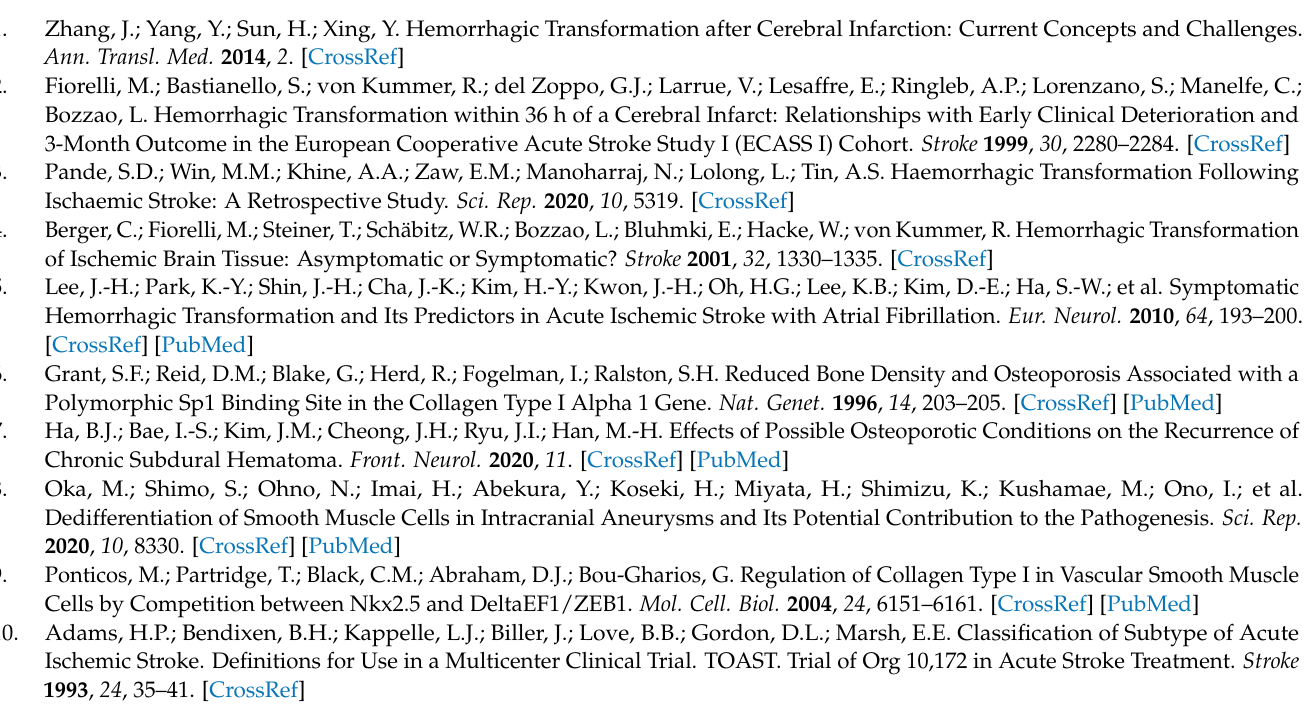
cancellous bone, Figure S2: Examples of PH type 1 and 2 HT in study patients with cardioembolic stroke, Figure S3: Measurement of the cerebral infarction volume, Figure S4. Scatterplots with linear regression lines, Table S1: Characteristics of the study individuals focusing on the PH-type HT and hypothetical BMD classification according to three different age groups, Table S2: Univariate Cox regression analyses of PH-type HT development after cardioembolic stroke according to hypothetical BMD classification based on different age groups, Table S3: Univariate Cox regression analyses of potential predictive factors of PH-type HT in patients with cardioembolic stroke, Table S4: Uni- and multivariate Cox regression analyses of potential predictive factors for PH-type HT among female patients with cardioembolic stroke, Table S5: Uni- and multivariate Cox regression analyses of potential predictive factors for PH-type HT among male patients with cardioembolic